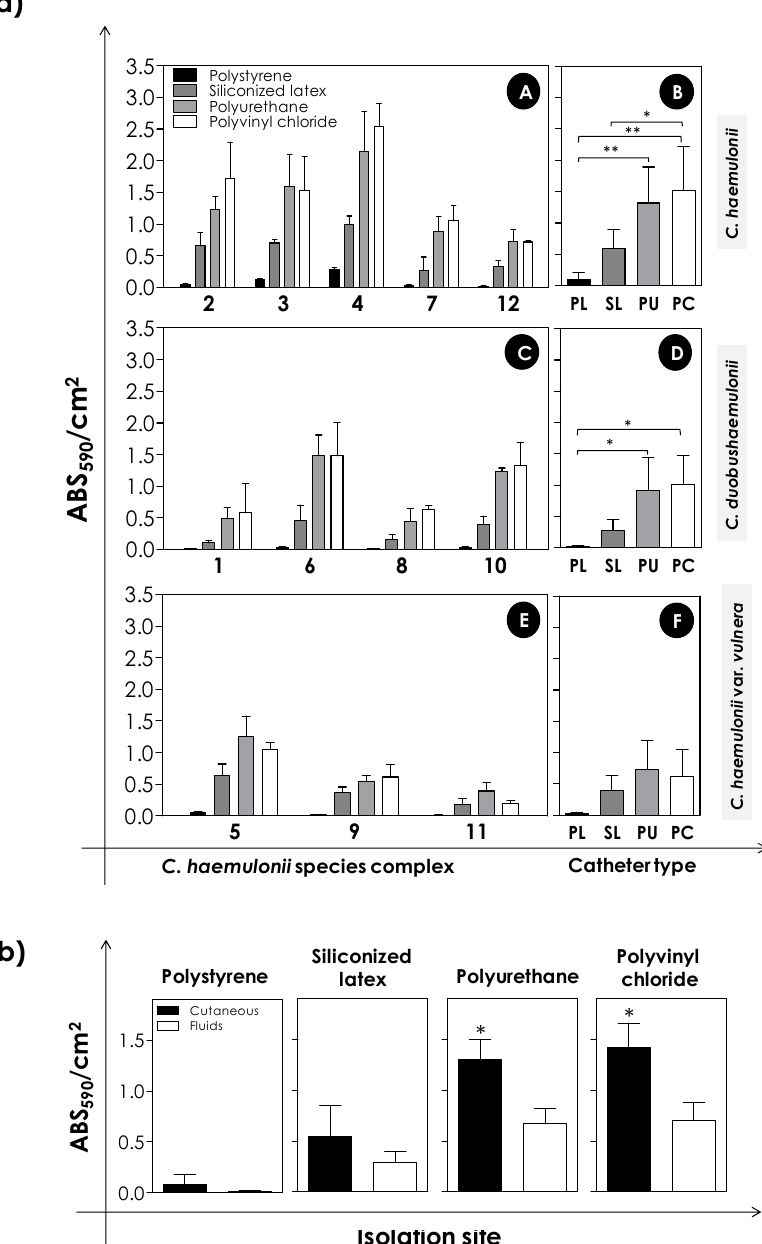
Figure 6. Biofilm formation on di ff erent catheter types by clinical isolates comprising the C. haemulonii complex. Fungal cells (200 µ L containing 10 6 cells) were placed to interact with polystyrene (PL) and di ff erent types of catheters (siliconized latex, SL; polyurethane, PU; and polyvinyl chloride, PC) for 48 h at 37 ◦ C. Subsequently, the biofilm biomass was measured by the crystal violet incorporation (590 nm). ( a ) The results were expressed as ABS 590 / cm 2 for each clinical isolate studied (A,C,E) and mean per each catheter type (B,D,F). Values represent the mean ± standard deviation of three independent experiments. The (*) indicates p -values < 0.05 and (**) p -values < 0.01 (one-way ANOVA, Tukey’s multiple comparison test). The numbers on the X-axis of the graphs represent each of the 12 clinical isolates of the C. haemulonii complex studied. ( b ) Comparison of biofilm biomass produced by the clinical isolates on polystyrene and each catheter type regarding the isolation sites (cutaneous and fluids). The 12 isolates were divided into two groups: cutaneous, including nail and skin ( n = 7); and fluids, including blood, urine, and bronchoalveolar lavage ( n = 5) (Table 1). (*) indicates p -values < 0.05 (unpaired Student’s t -test).